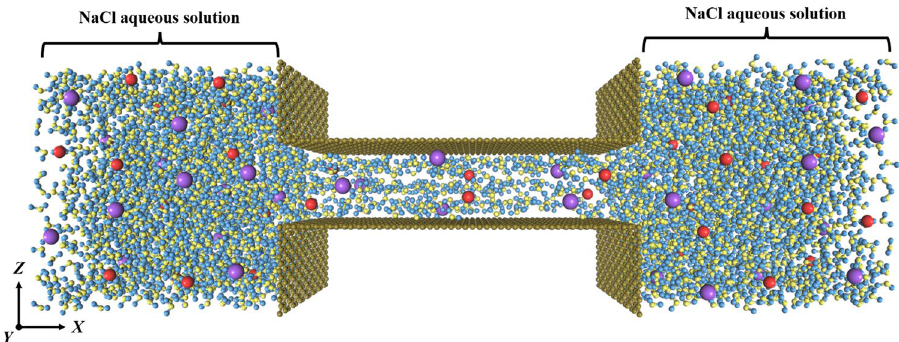
Figure 1. Perspective projection of the simulated nanochannel consisted of graphene bilayers and two reservoirs of NaCl aqueous solution at both ends. Dark green color corresponds to the graphene sheets, blue the hydrogen, and yellow the oxygen atoms. Red and violet colors indicate the Na + and Cl − ,